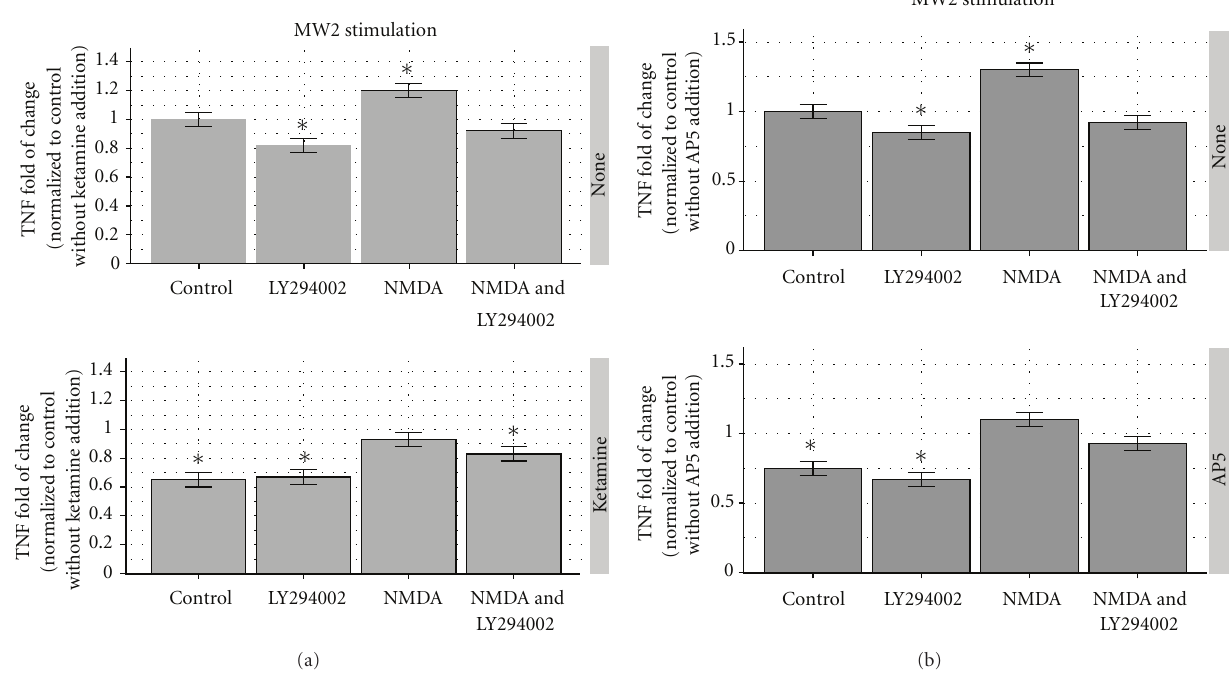
Figure 1: (a) Ketamine and the PI3K/Akt inhibitor LY294002 modify TNF production by RAW264.7 murine macrophages. In the upper panel, compared to the not treated control-first column, MRSA-MW2 (USA400) stimulated less TNF secretion (18%) by macrophages when exposed to LY294002 (second column), more secretion (20%) when exposed to NMDA substrate (third column), and was not significantly di ff erent from the control TNF secretion (8% decrease) when both NMDA and LY294002 were present (fourth column). In the lower panel, ketamine (first column) was added and suppressed TNF production 35% less than the control (upper panel, first column). Ketamine and LY294002 (lower panel, second column) also caused TNF suppression (33%), but when compared with ketamine alone (lower panel, first column), the suppression was not significantly di ff erent. Ketamine and NMDA caused a 7% TNF increase (not di ff erent from the control at P < 0 . 05), and ketamine-NMDA with LY294002 caused 17% TNF suppression. The results are depicted as fold of change compared to the control with 95% confidence intervals shown as “error bars.” ∗ P < 0 . 05. The control response was 33,561 ± 842 pg/mL. (b) AP5 (APV), another NMDA inhibitor, modified TNF production by RAW264.7 murine macrophages in a way similar to that of ketamine. In the upper panel MW2 (USA400) stimulated 15% less TNF secretion by macrophages when exposed to LY294002 (second column), 30% more when exposed to NMDA substrate (third column)—both significantly di ff erent from the untreated control (upper panel, first column) at P < 0 . 05. The TNF secretion in the presence of both NMDA and LY294002 (upper panel, fourth column) was not significantly di ff erent from the control. In the same experimental sequence in the lower panel, AP5 caused significant suppression of TNF production (25%—lower panel, first column) in a manner similar to that of ketamine (Figure 1, lower panel, first column). Of the rest, only the combination LY294002 and AP5 (second column) caused a significant suppression (33%) compared to control ( P < 0 . 05). The results are depicted as fold of change compared to the control with 95% confidence intervals shown as “error bars.” ∗ P < 0 . 05. The control response was 30,221 ±